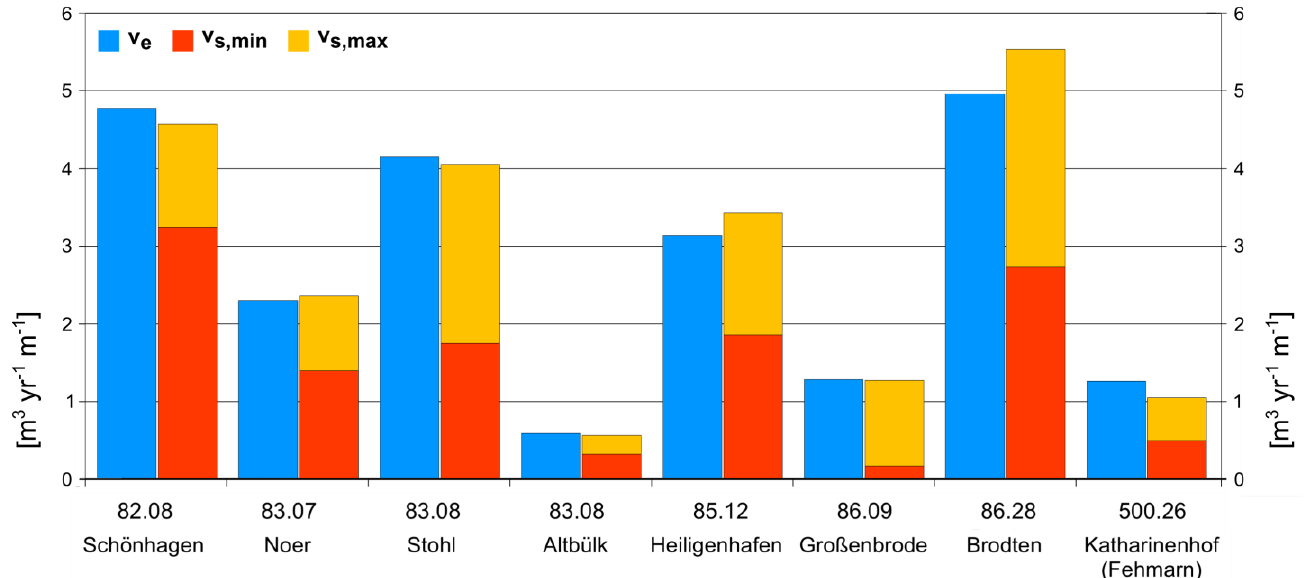
Figure 4. Specific erosional volume v e (blue) based on cliff retreat [36] and the calculated sediment budget range, v s,min (orange) to v s,max (yellow), for the eight well-studied cliff locations. For specific values see Table A2.